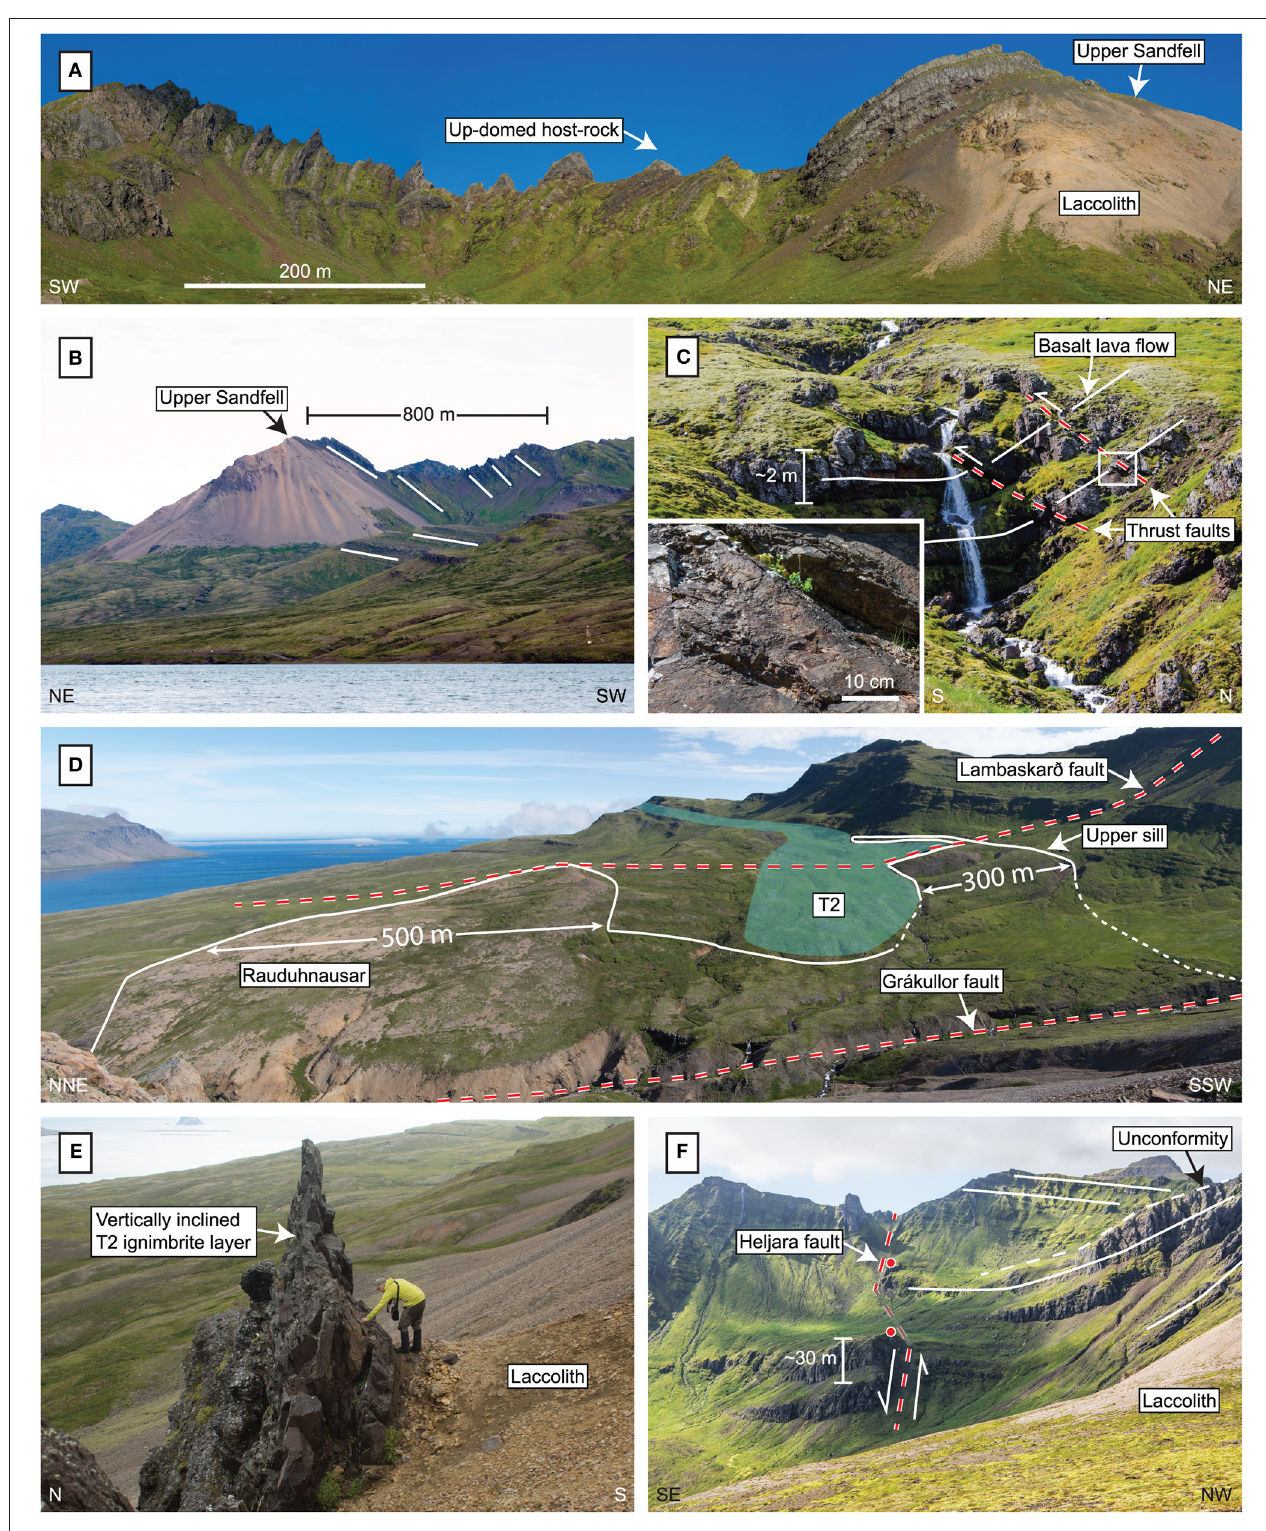
FIGURE 2 | (A) Photo of basaltic lavas (dark rock) and silicic pyroclastic (light rock) layers up-domed by the emplacement of the Sandfell laccolith. Image location is given in Figure 1B . (B) View from the northern shore of Fáskrúðsfjörður looking toward the SE and the Sandfell laccolith. Note the differences in dip between the lava pile in front of the laccolith and the lava pile next to the laccolith. (C) View toward west and a discrete kink (monocline) in the basalt host rock that marks the